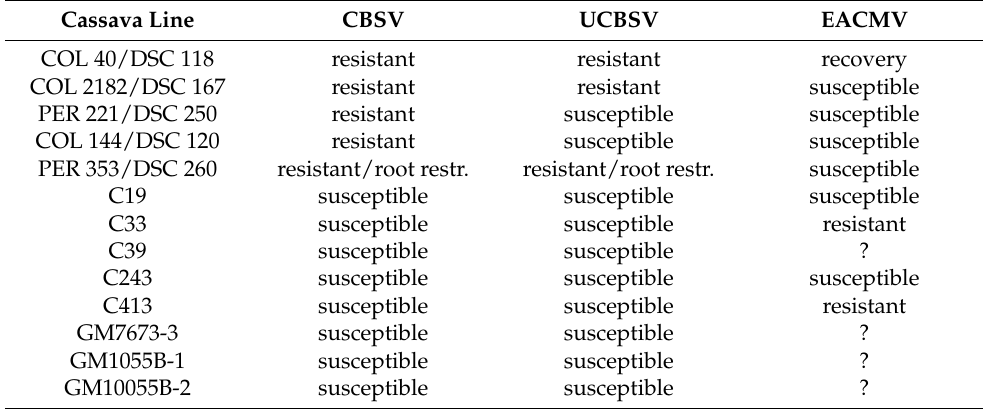
Table 1. Resistance status of cassava lines used as crossing parents at CIAT. The virus resistance status was determined experimentally at DSMZ following earlier studies